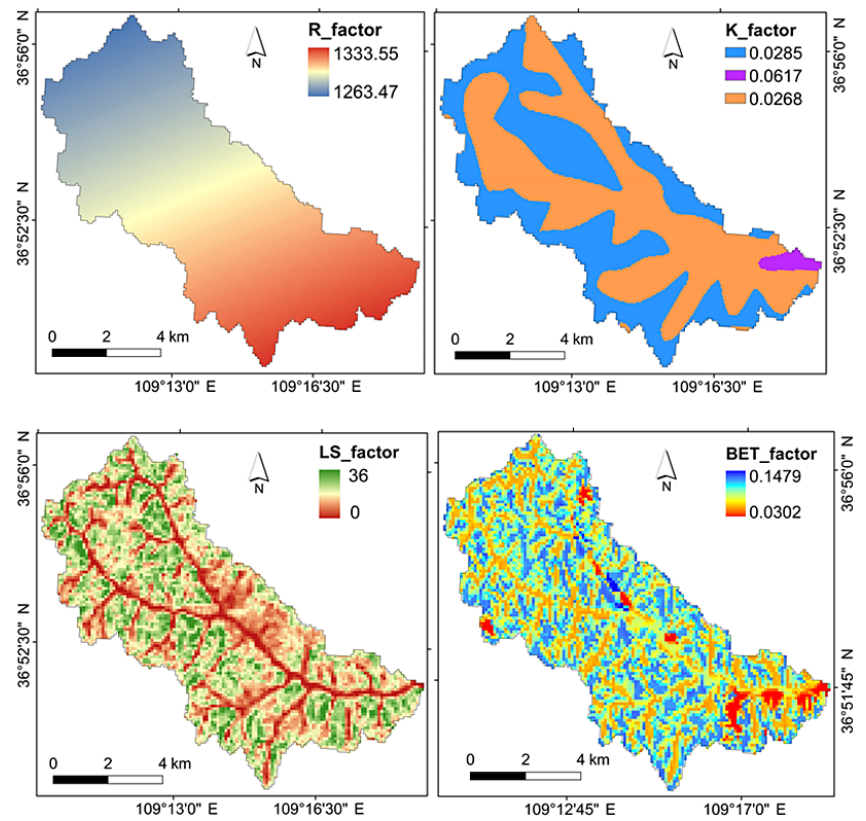
Figure 4. From left to right and up to down: spatial distribution of the annual average R factor, K factor, LS factor, and BET factor in the Majiagou River